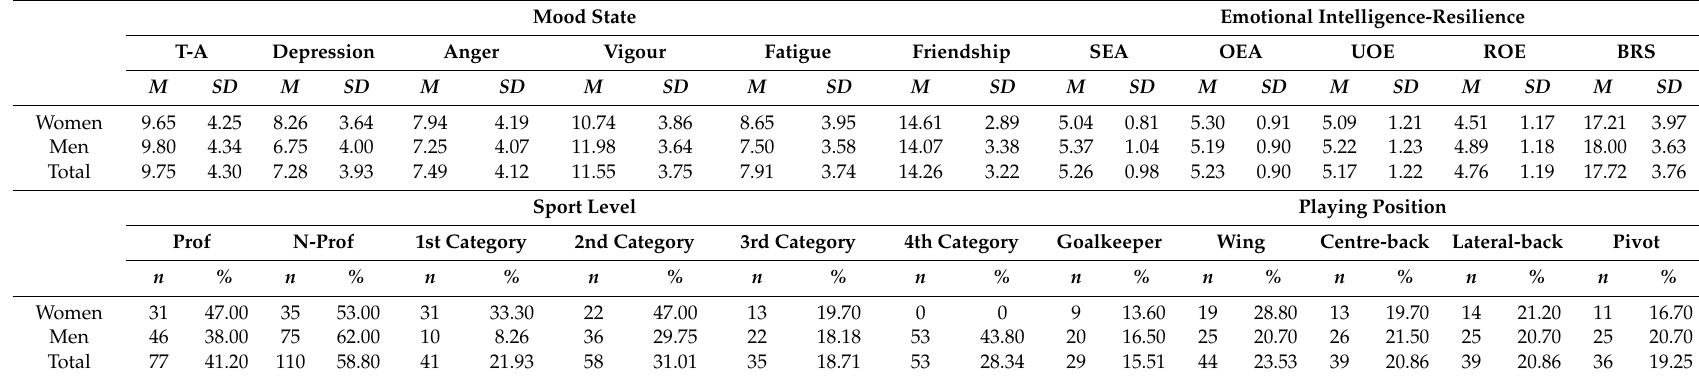
Table 1. Descriptive distribution of the handball players by gender (women, men, and total) according to mood state, emotional intelligence (EI) and resilience, sport level (condition and category), and playing